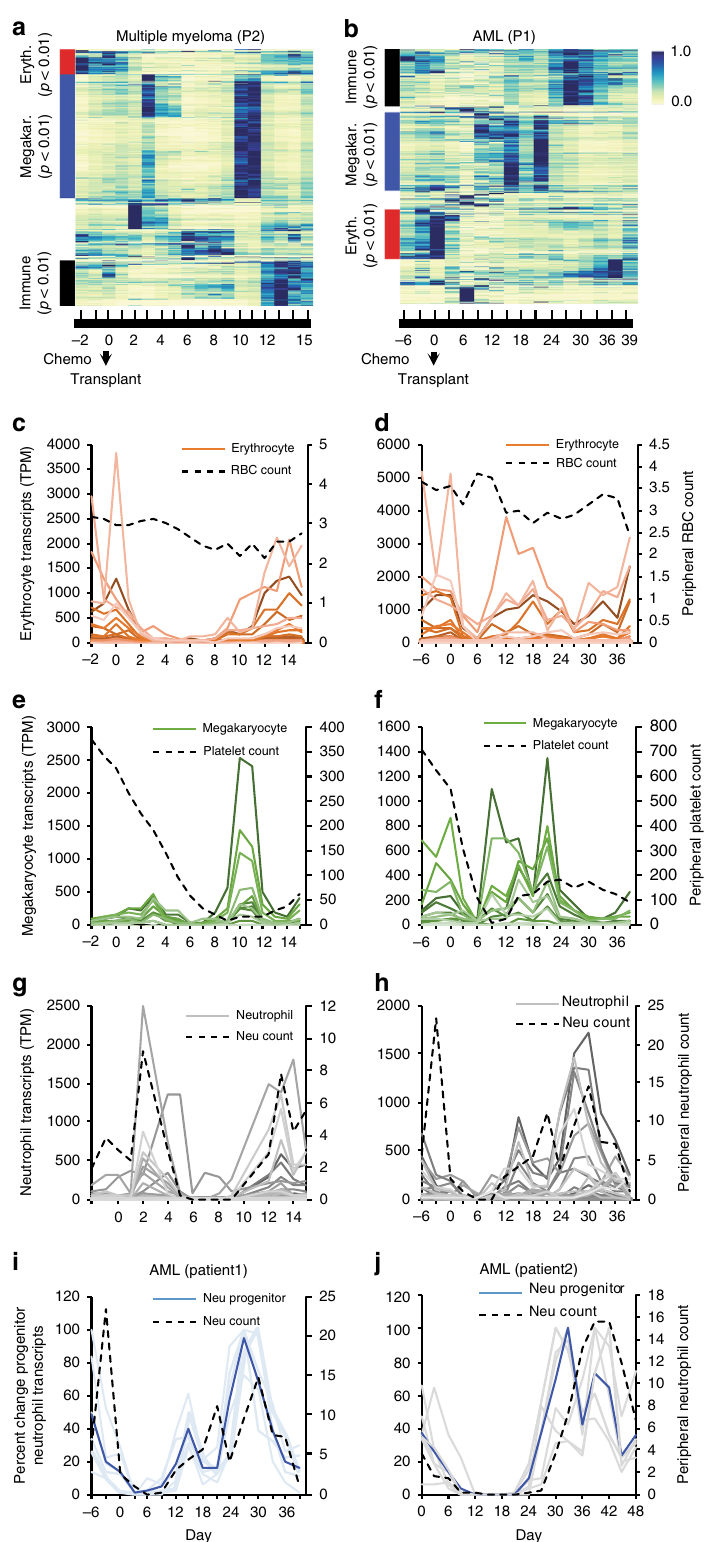
variants from donor cells (Fig. 4a). Indeed, cf-mRNA pro fi ling enabled monitoring of changes in these transcripts during therapeutic treatment of patients 1 and 2 (Fig. 4b – c). Combined analysis of all detected SNP from the host switching to a different genetic variant after transplant (e.g., from homozygous to heterozygous) indicates that multiple genetic differences can